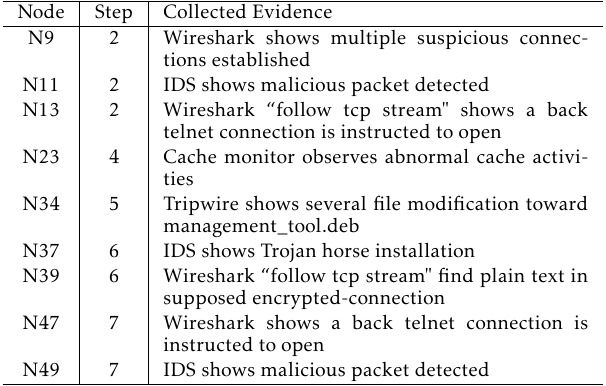
Table 3. Collected Evidence Corresponding to Attack